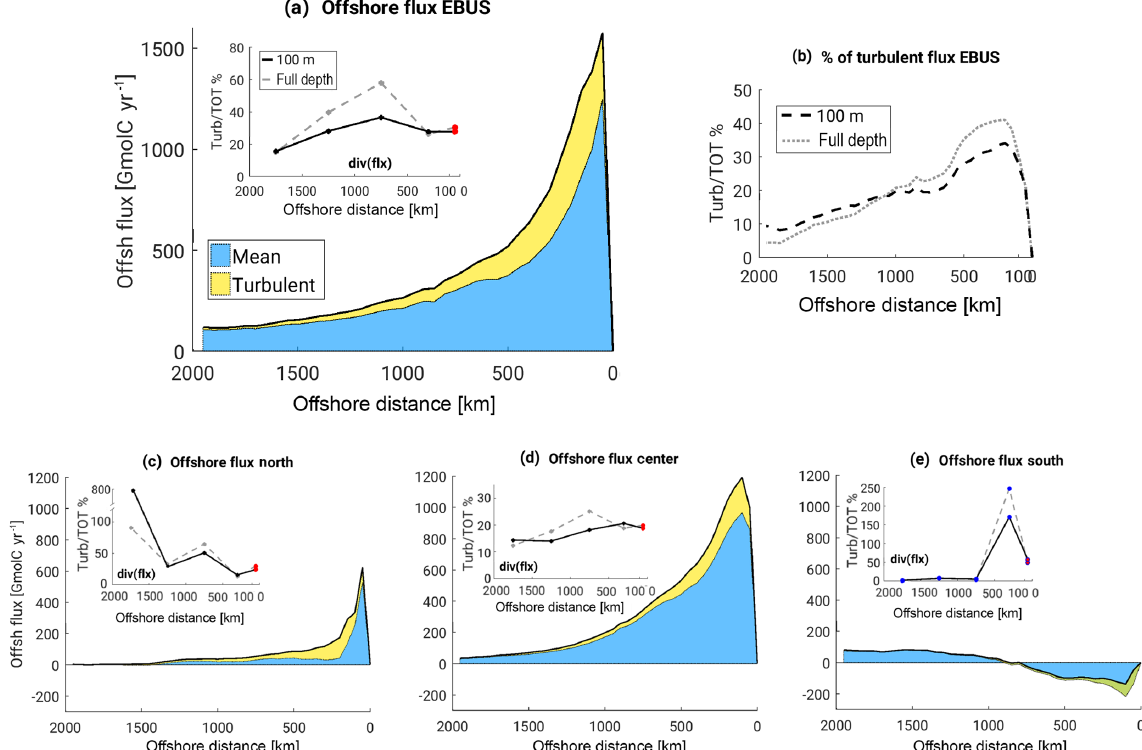
Figure 6. Magnitude of the mean and turbulent components of the offshore flux [GmolCyr − 1 ]: (a) Canary EBUS as a whole; (c) northern CanUS; (d) central CanUS; (e) southern CanUS. In all area plots, the black thick line is the total offshore flux, sum of mean and turbulent fluxes; fluxes are integrated in the first 100m depth. (b) Only for the full EBUS we show the ratio of the magnitude of the turbulent/total offshore flux, integrated in the first 100m and throughout the whole water column. Inserts: ratio between the absolute value of the divergence of the turbulent component and that of the total flux, integrated in the first 100m depth (black line) and over the full water-column (gray line). Per each offshore range, divergences are calculated as finite differences at the boundaries shown on the x axis. Dots are red when both total and turbulent divergences are negative (fluxes remove C org ); dots have the same color of the line when both divergences are positive (fluxes add C org ). In the southern subregion only, blue dots indicate that the divergence of the turbulent flux (positive) opposes the divergence of the mean flux (negative); the opposite is true for red dots with a blue contour. The green area shading results from the overlapping of opposing mean and turbulent flux